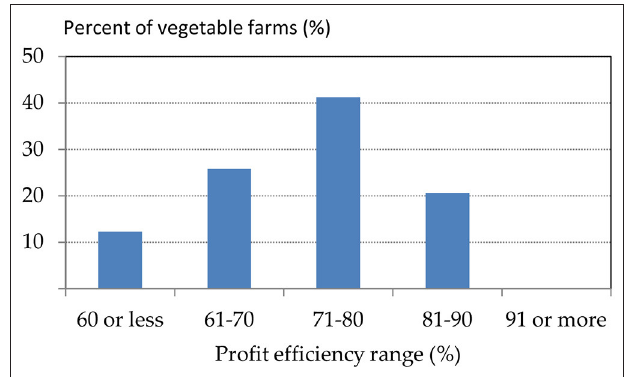
FIGURE 1 | Profit efficiency score distribution of vegetable farms. Source: Authors’ calculation from the field survey data (2013).